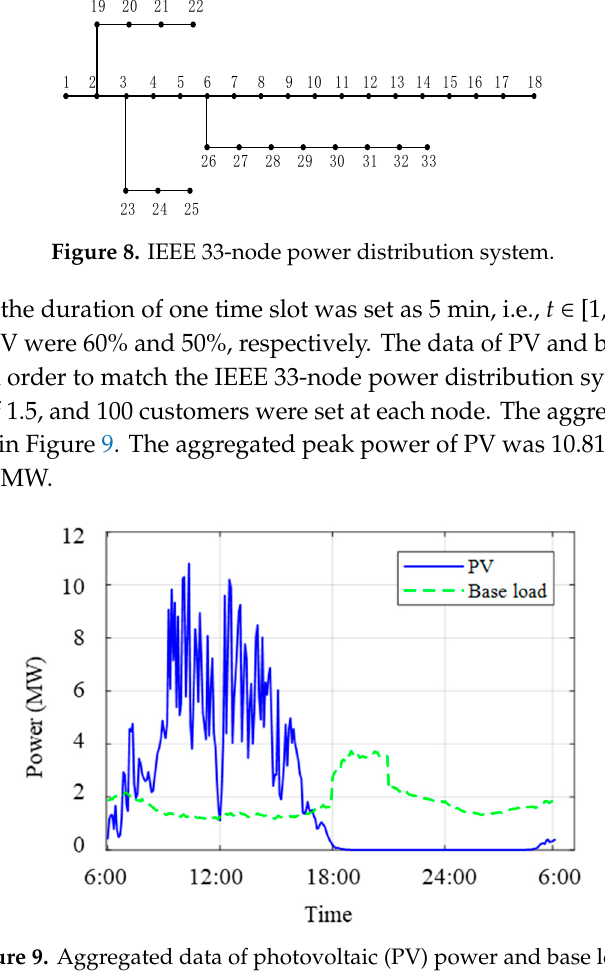
Figure 9. Aggregated data of photovoltaic (PV) power and base load.